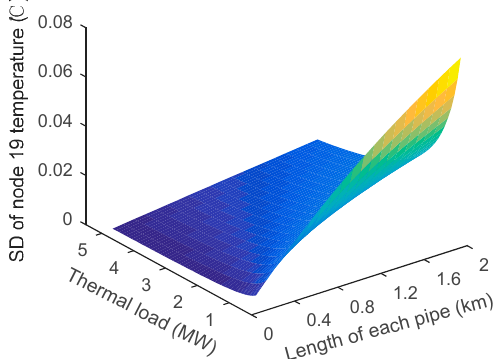
Figure 9. Relationship between the node temperature standard deviation of node 19 with respect to pipe length and mean thermal load (Test 4: σ ϕ = ±10%).